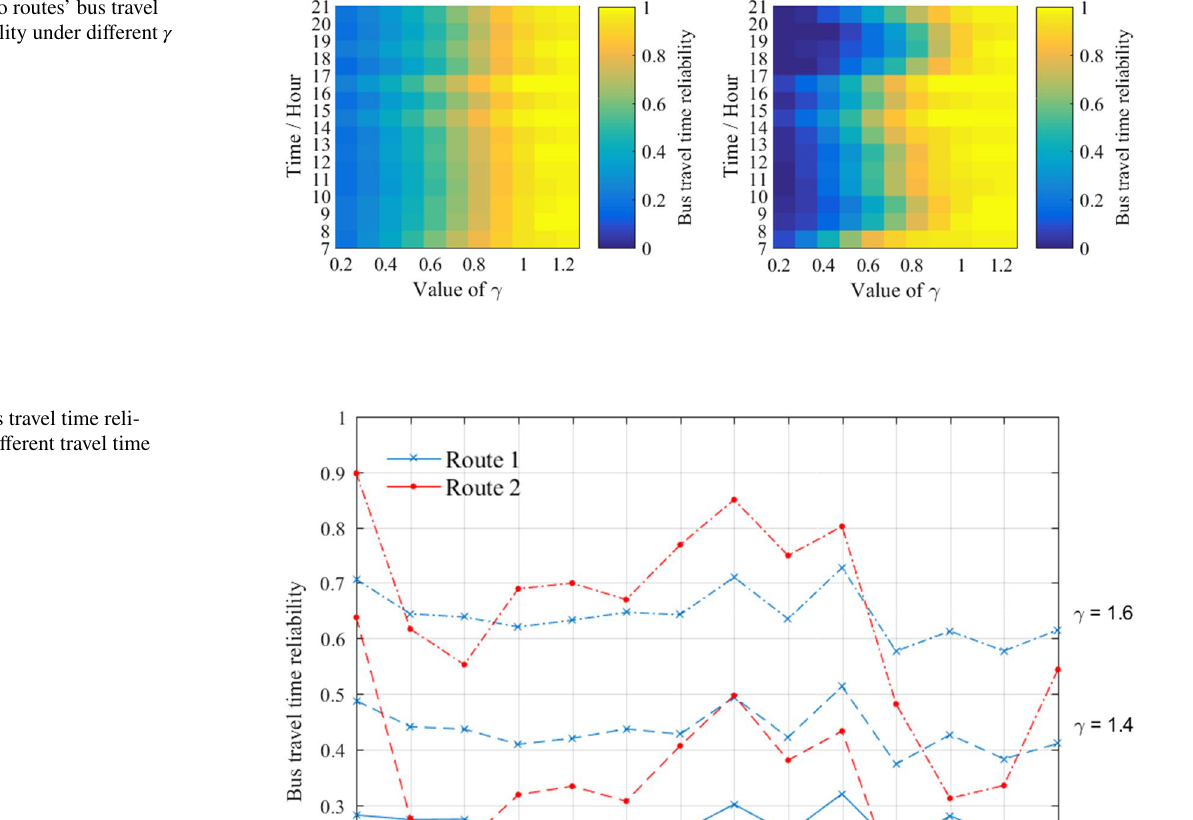
Fig. 15 Two routes’ bus travel time reliability under different 𝛾